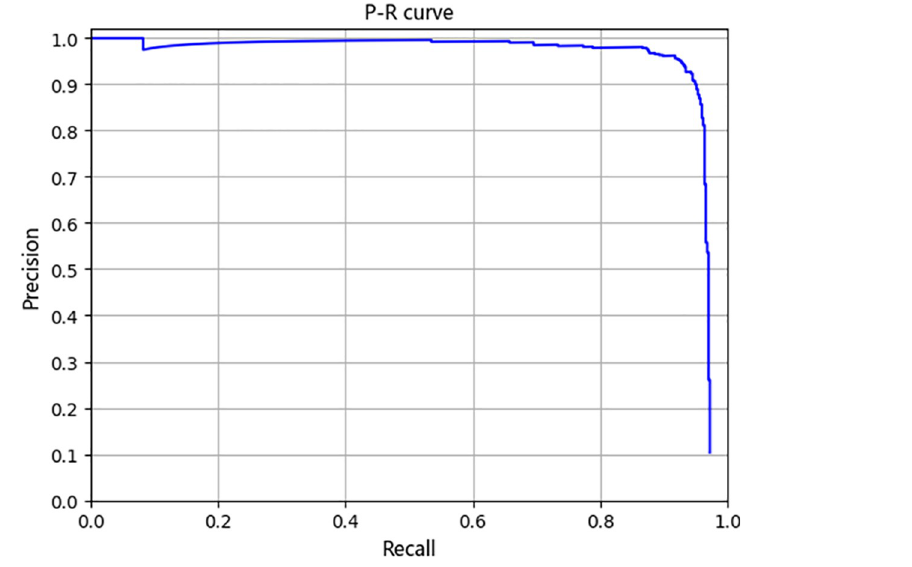
Fig 7. The P-R curve of our framework on VEDAI.